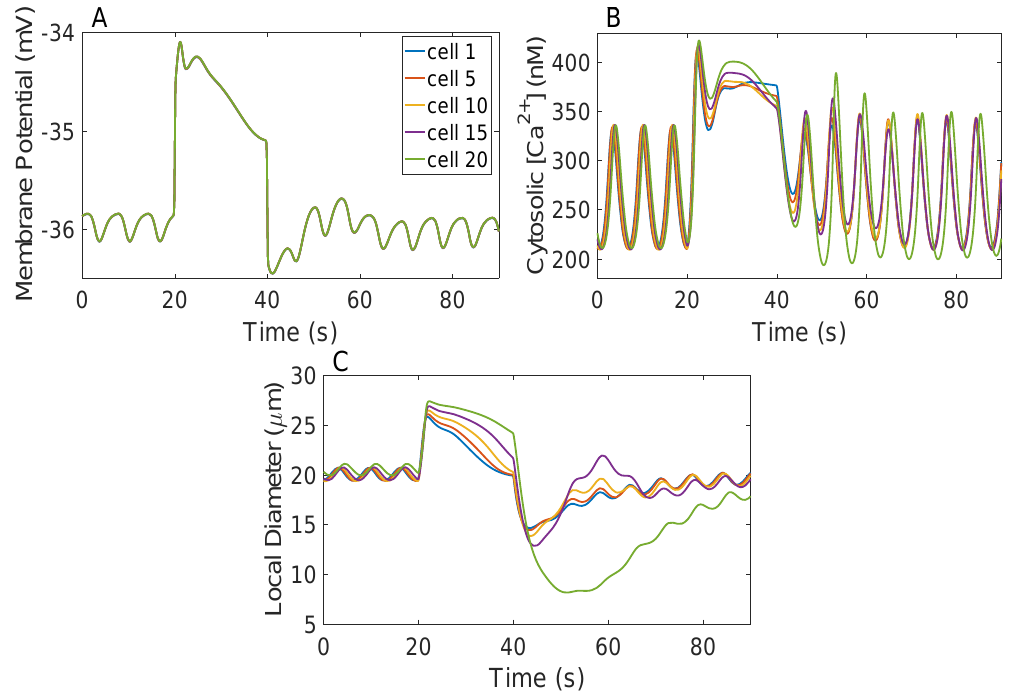
Figure 8. Predicted time profiles of ( A ) membrane potential; ( B ) cytosolic Ca 2 + concentration; and ( C ) local diameter for five cells in the afferent arteriole at an inflow pressure pulse increase to 140 mmHg. For clarity, we only show one in 5 cells along the AA; the behavior of neighboring cells is summarized in Section